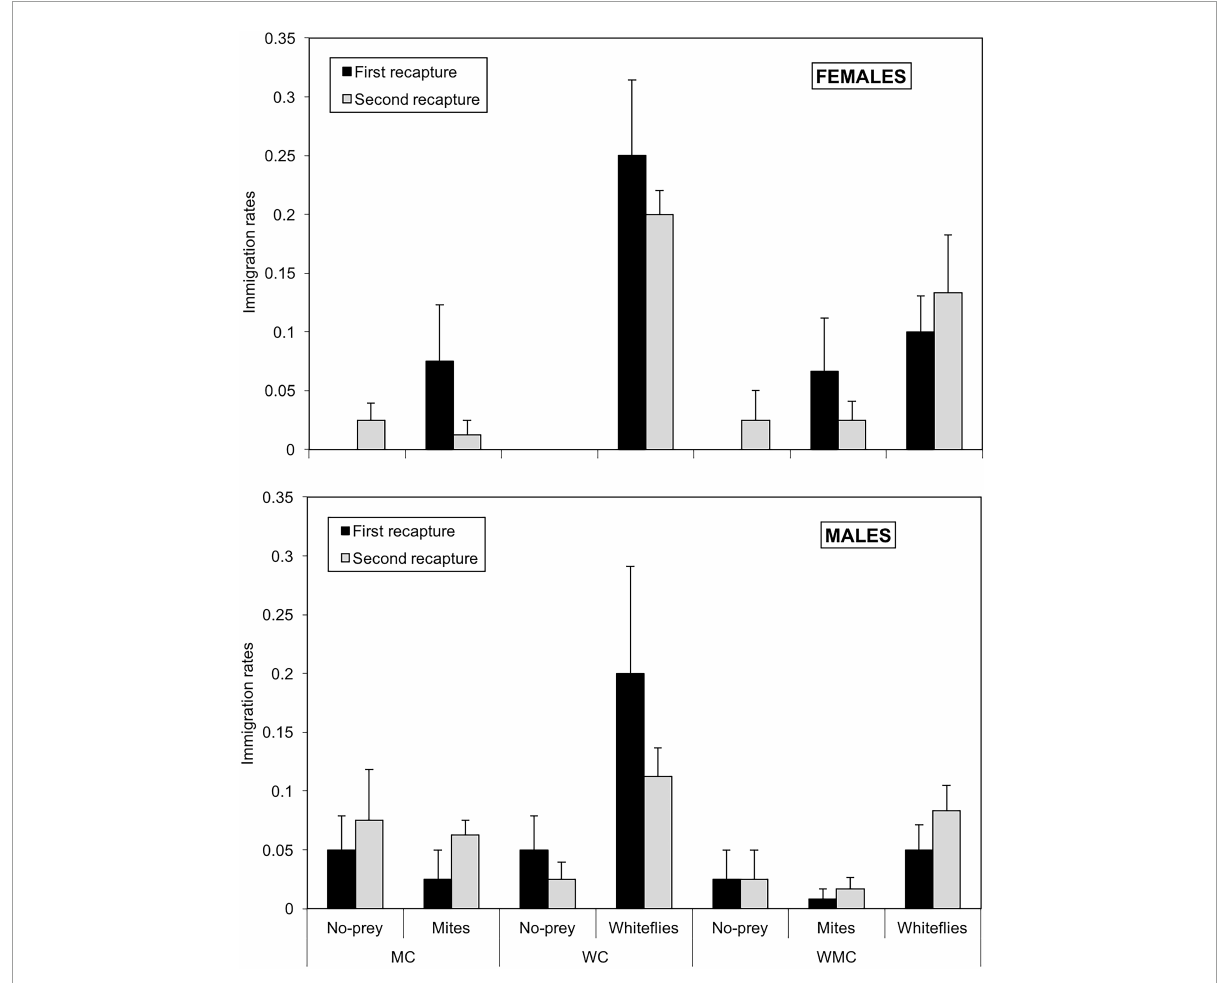
FIGURE6 Immigration rates of females (upper graph) and males (lower graph) of D. hesperus per plant with standard errors, in three habitats (MC, WC, and WMC) composed by patches with different food resources (No prey- C-, mites- M-,